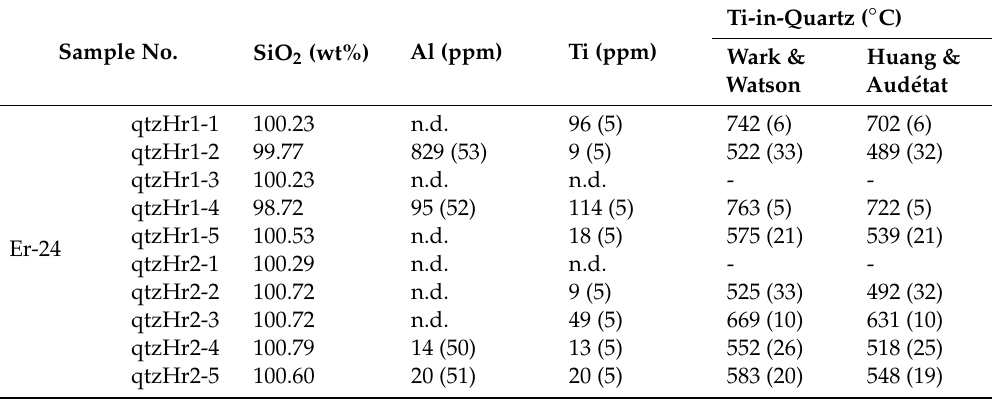
Table 1. Compositions of quartz phenocrysts in the host granodiorite porphyry (number in parentheses next to each analysis represents 1 σ and given in the term of the least unit cited; n.d. = not detected).